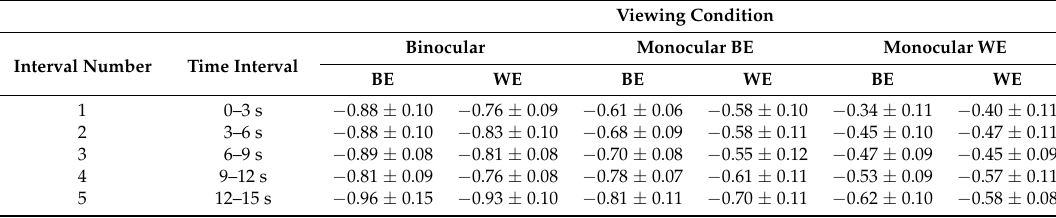
Table 3. Fixation stability quantified by logBCEA (mean ± SD) for the BE (better eye) and WE (worse eye) during binocular and monocular viewing conditions for the AMD group.